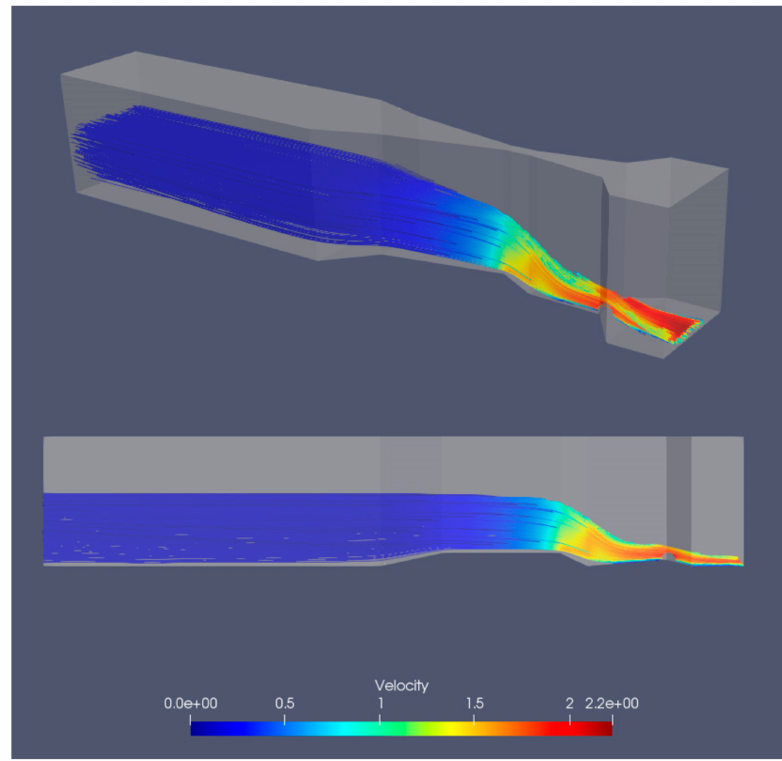
Figure 10. 3D and side view of the velocity field of the flume with a flowrate of 10